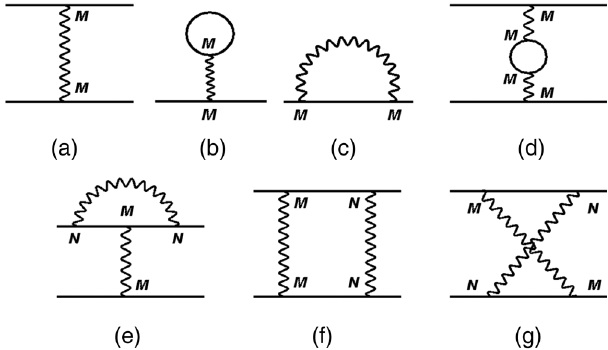
FIG. 6. (a) Bare four-fermion interaction vertex ð ψ † M ψ Þ 2 (for spinless fermions) or ð Ψ † M Ψ Þ 2 (for spin- 1 /2 electrons). The Feynman diagrams contributing to the renormalization group flow equations to the leading order in ϵ and 1 / n expansion are shown as (b) – (g). Here, M and N are 2 × 2 (for spinless fermions) and 4 × 4 (for spin- 1 /2 electrons) Hermitian